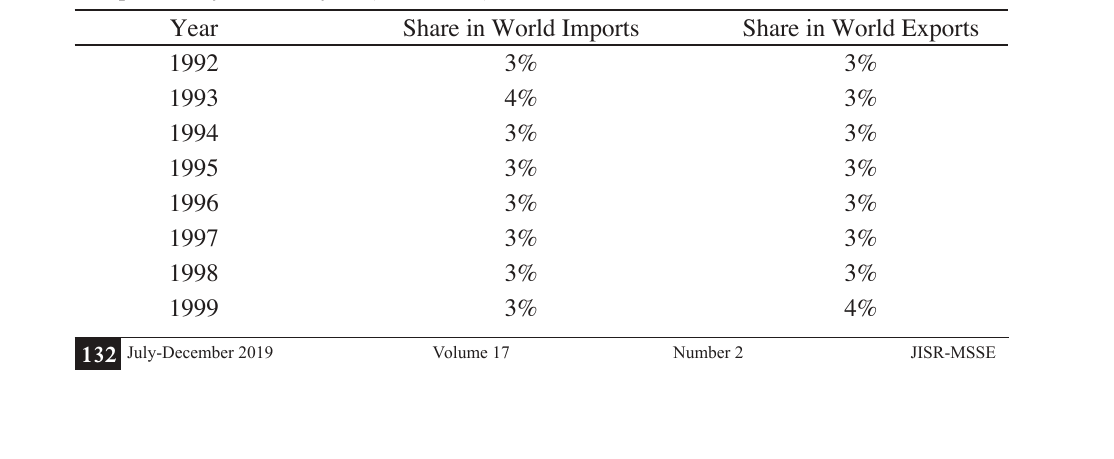
Comparison of Trade Deficit